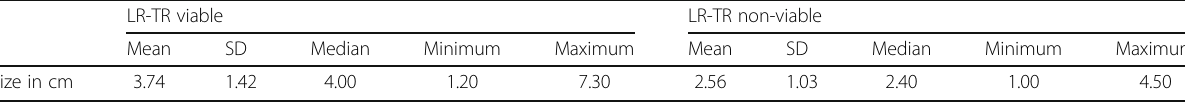
Table 2 Diameter in cm (40 treated observations) LR-TR viable LR-TR non-viable Mean SD Median Minimum Maximum Mean SD Median Minimum Maximum Size in cm